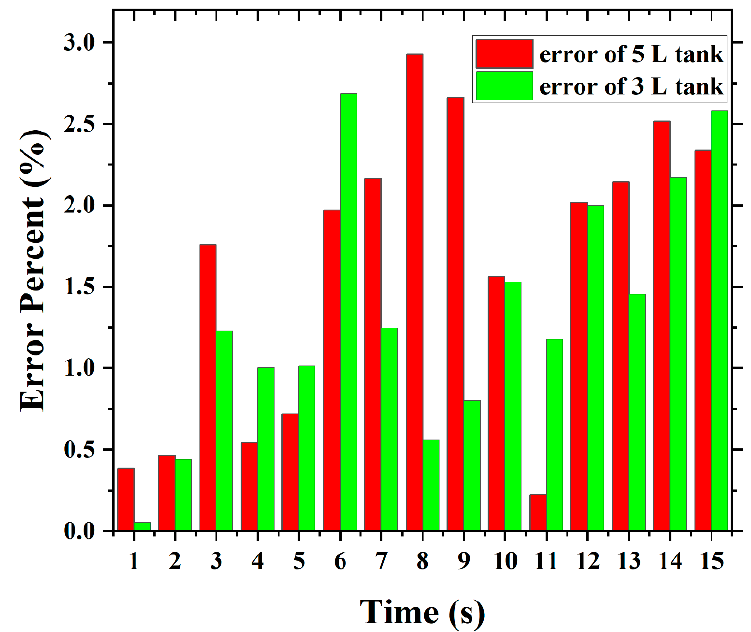
Figure 8. Experimental error diagram of overall heat transfer coefficient.